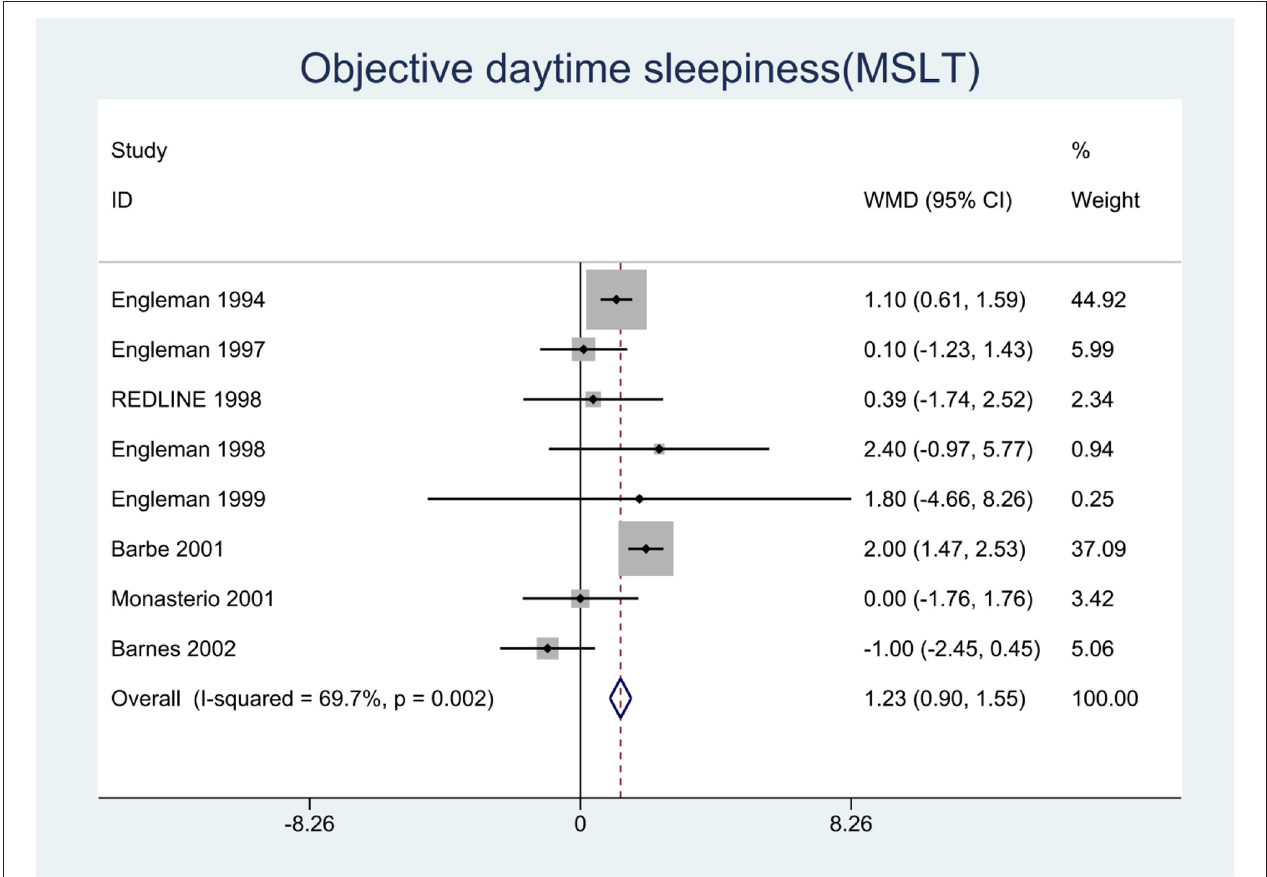
FIGURE 3 | Forest plot showing pooled weighted mean difference (WMD) for Multiple Sleep Latency Test (MSLT) in studies on continuous positive airway pressure (CPAP), compared with control group.